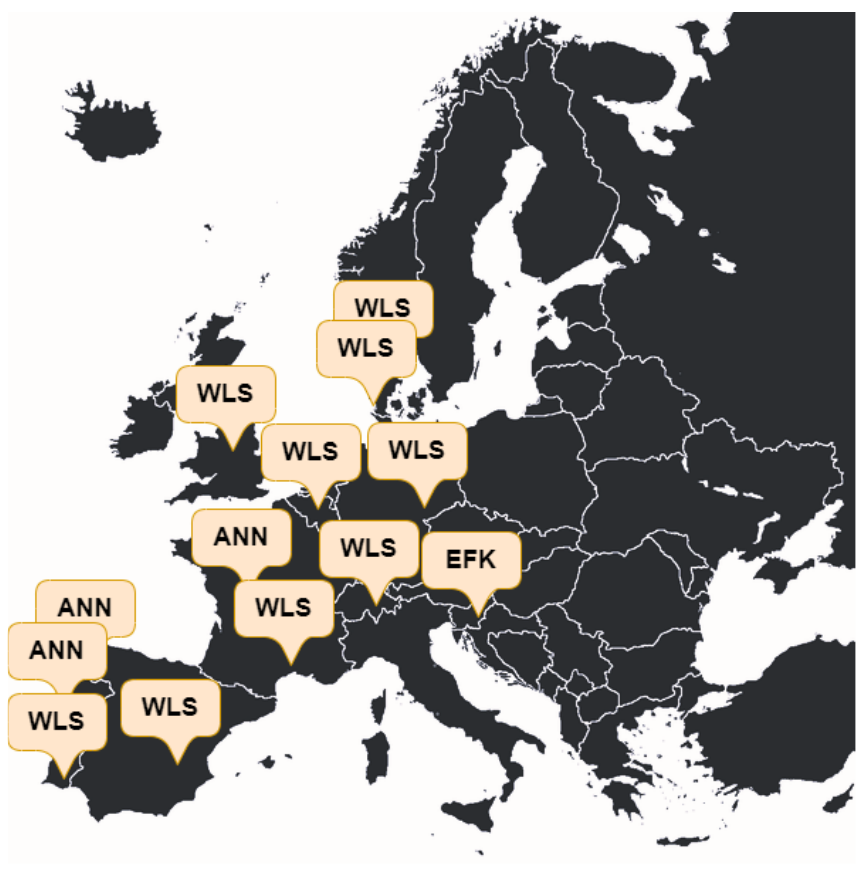
Figure 5. DSSE pilot project implementation [50,120,138 – 145].